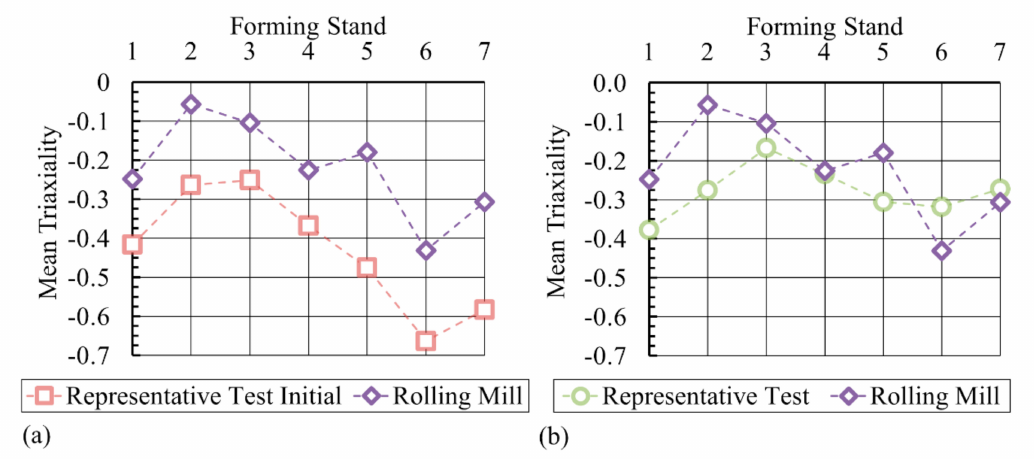
Figure 9. ( a ) Mean triaxiality level comparison between the initial representative test and the rolling mill and ( b ) between the corrected representative test and the rolling